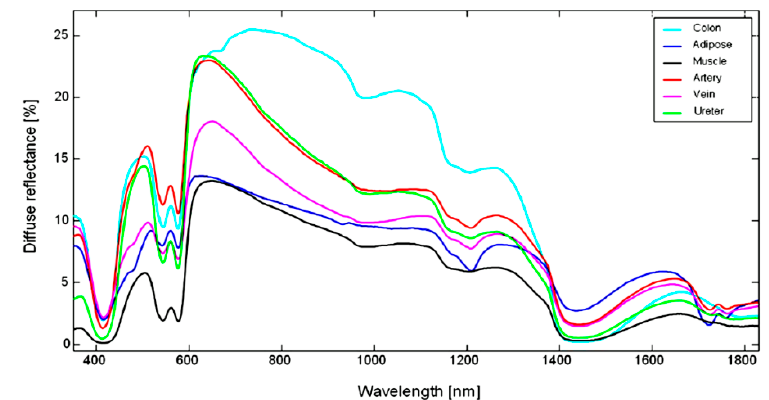
Figure 6. Mean spectra per tissue type acquired during colorectal surgery in [62]. Average tissue spectra for ureter (green), mesenteric adipose tissue (dark blue), artery (red), colon (light blue), muscle (black), and vein (purple).